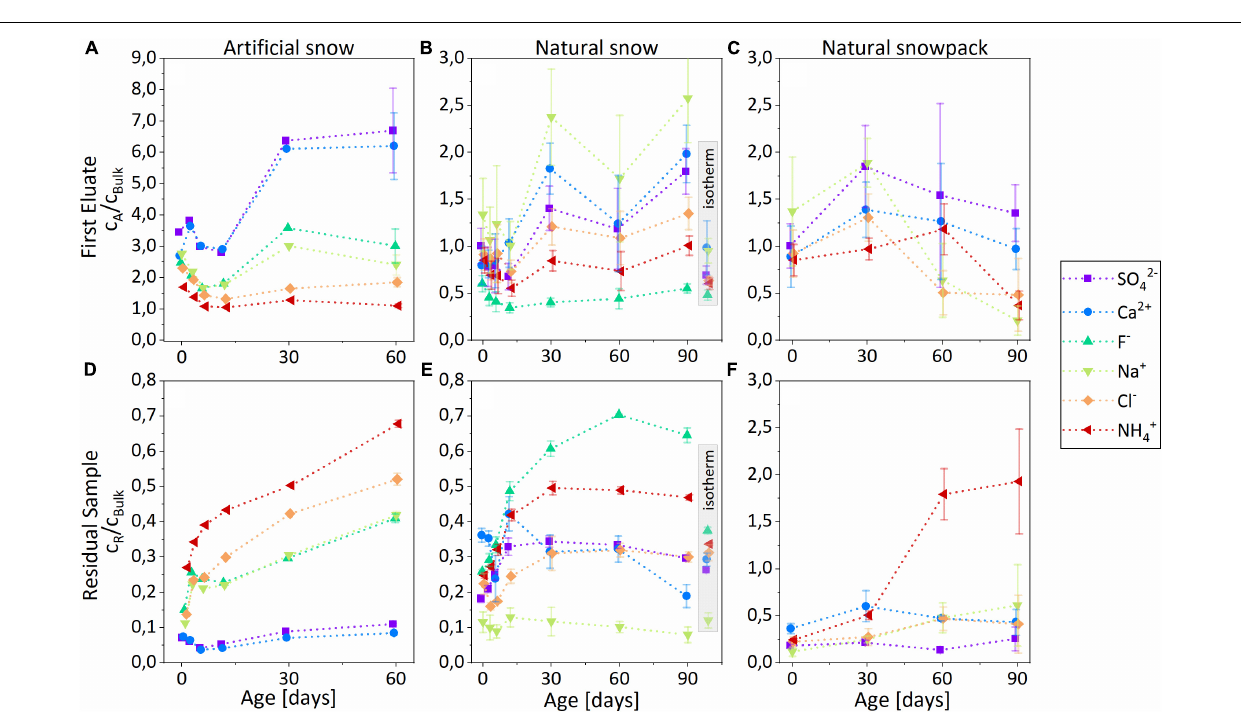
FIGURE 6 | Temporal evolution of normalized ion concentrations c A /c Bulk in the first eluates (A–C) and c R /c Bulk in the residual samples (D–F) . (A,D) Controlled metamorphism, artificial snow. (B,E) Controlled metamorphism, natural snow. (C,F) Natural metamorphism, natural snowpack. Error bars represent 1 σ uncertainties of three replicated samples. Data points within the gray bars (panels B,E ) represent a sample isothermal stored for 90 days at –20 ◦